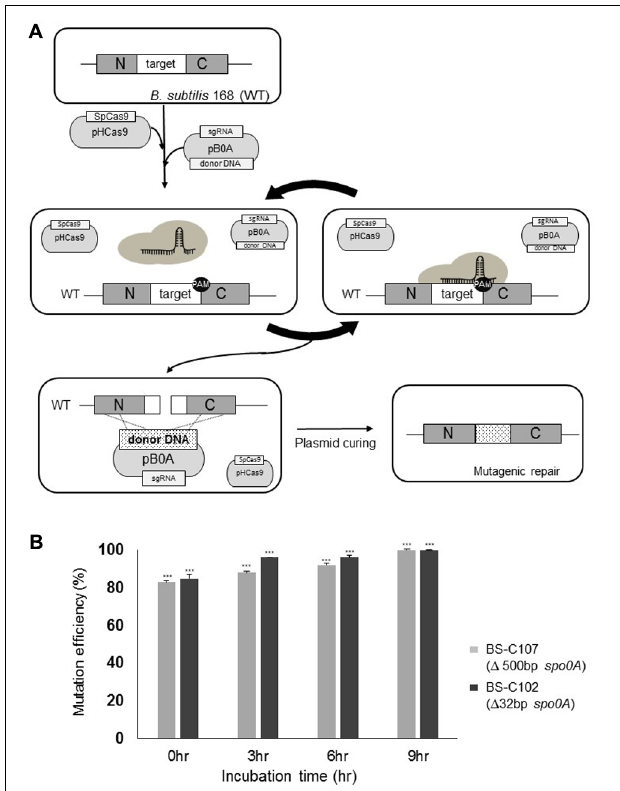
FIGURE 4 | Iterative genome engineering system scheme. (A) Introduction of pHCas9 and pB0A into B. subtilis 168 allowed generation of spo0A -targeting sgRNA and SpCas9 complex. Prolonged incubation under the appropriate selection pressure allowed iterative DSB to occur on the spo0A target region until it becomes a desired mutant. (B) BS-C102 (black) and BS-C107 (gray) mutant strains were used to determine iterative genome engineering system under selective antibiotic conditions. Two strains showed an average mutation efficiency of 85% without prolonged incubation. Longer incubation resulted in a time-dependent increase in mutation efficiency, up to a maximum of 100%. Means of three independent technical replica experiments are presented; the error bars indicate standard deviations. ∗∗∗ P < 0.001 compared with control without presence of